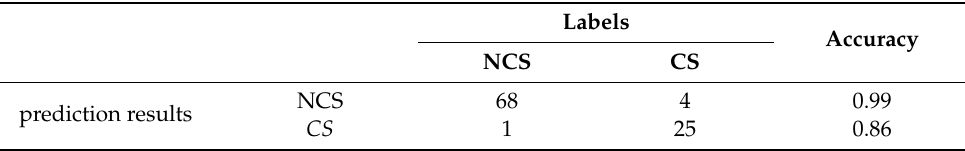
Figure 10. Prediction accuracy of coping skills for older drivers. Table 14. Results of predicting the coping skills of older drivers based on driving behavior using random